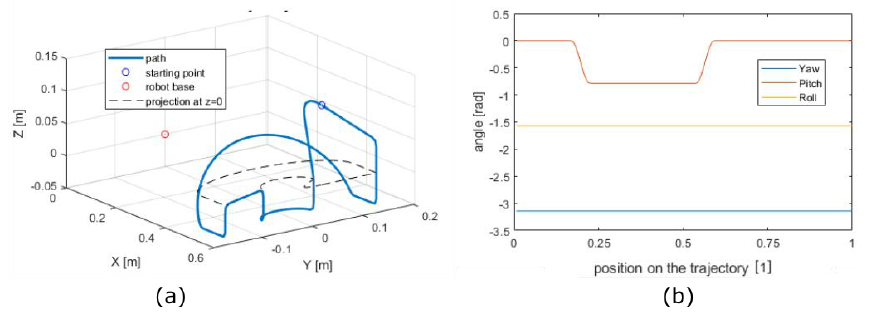
Figure 10. Task 3: ( a ) position; ( b ) orientation.